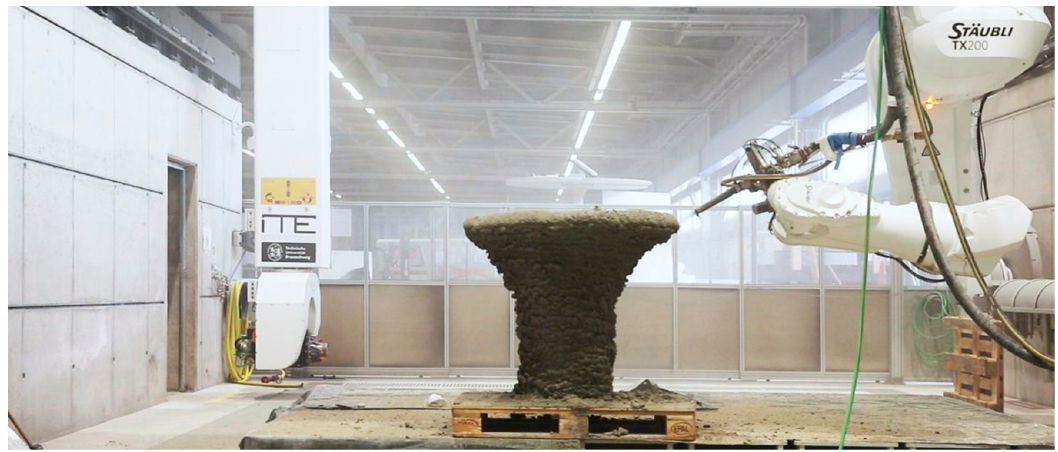
Figure 2. Digital Building Fabrication Laboratory (DBFL) at Technische Universität Braunschweig, Germany ( © Institute of Structural Design Technische Universität Braunschweig), compare [25,29].